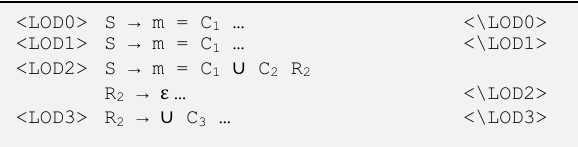
Figure 5. Production rules after first iteration.